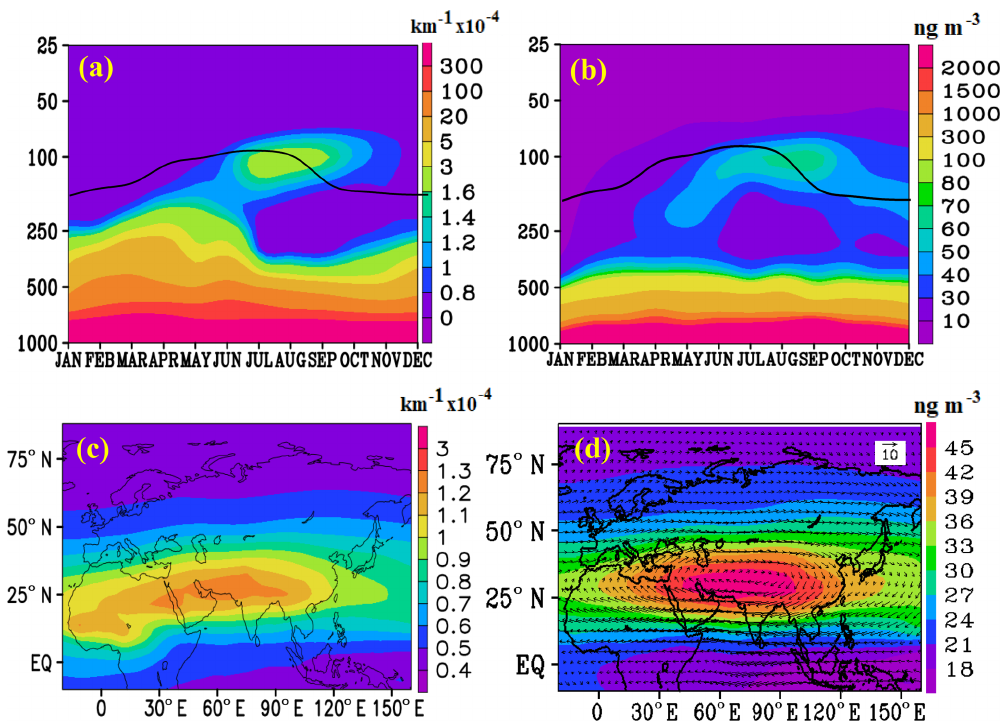
Figure 3. Monthly vertical variation in (a) extinction (km − 1 × 10 − 4 ) averaged for 25–40 ◦ N, 70–120 ◦ E; (b) same as (a) but for sulfate aerosols (ngm − 3 ); (c) distribution aerosol extinction (km − 1 × 10 − 4 ) at 100hPa averaged for the summer-monsoon season; (d) distribution of sulfate aerosol (ngm − 3 ) at 100hPa averaged for the summer-monsoon season. Wind vectors in (d) indicate the extent of the anticyclone. Panels (a) – (d) are obtained from CTRL simulations. The black line in (a) and (b) indicates the